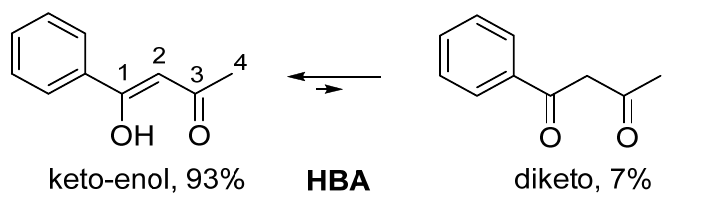
Figure 2. Tautomeric forms of benzoylacetone (HBA) in CDCl 3 in equilibrium at room tempera-